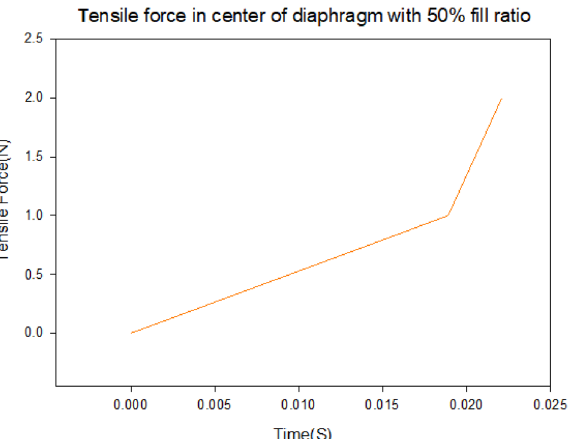
Fig. 20 The time function entered the center of the diaphragm at 50% filling